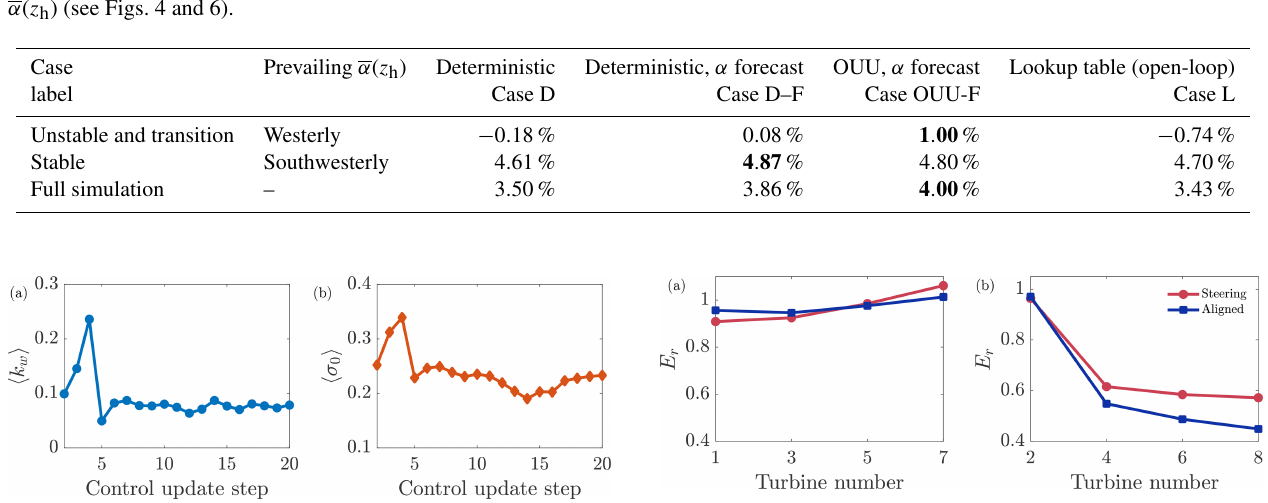
Table 3. Wind farm energy production increase compared to baseline yaw-aligned control; G = 100 · ( E r − 1) with E r in Eq. (6). Cases with α forecast use the DirectionEstimation algorithm. Case OUU-F uses stochastic programming for yaw set-point optimization under uncertainty (OUU). The case with the highest overall wind farm energy production for a given time period is shown in bold. The stable periods correspond to 0 < L < 200 with unstable and transition times otherwise. We note that the hub-height wind direction and wind speed also vary with stability. We denote the approximate mean wind direction at the wind turbine hub height during each stability period with α ( z h ) (see Figs. 4 and 6).